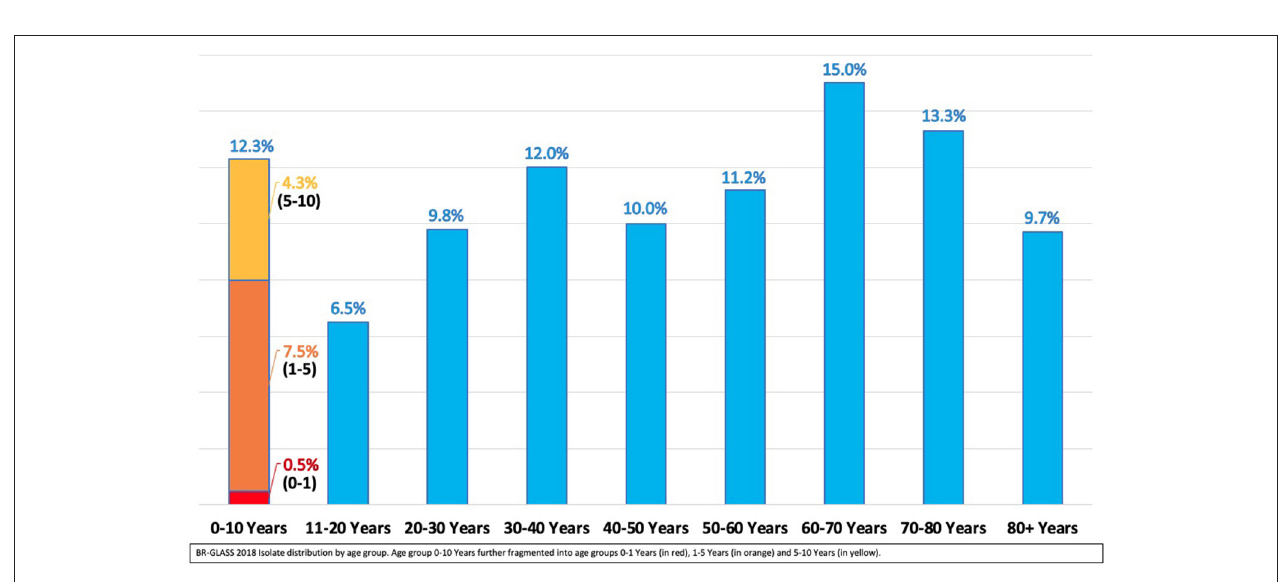
FIGURE 6 | BR-GLASS 2018 Isolate distribution by age